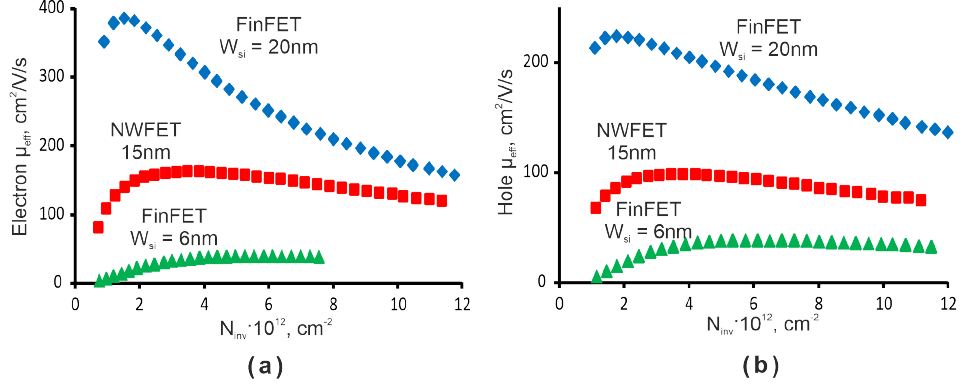
Figure 5. Electron ( a ) and hole ( b ) effective mobility vs. the inversion charge density (L = 600